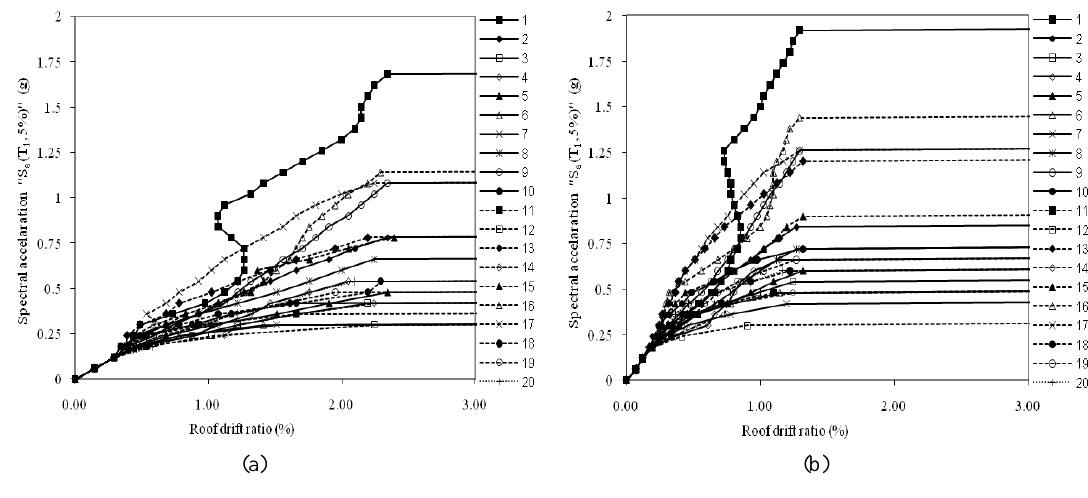
Fig. 13. IDA curves: (a) T: 0 (non-corroded), (b) T: 25 years